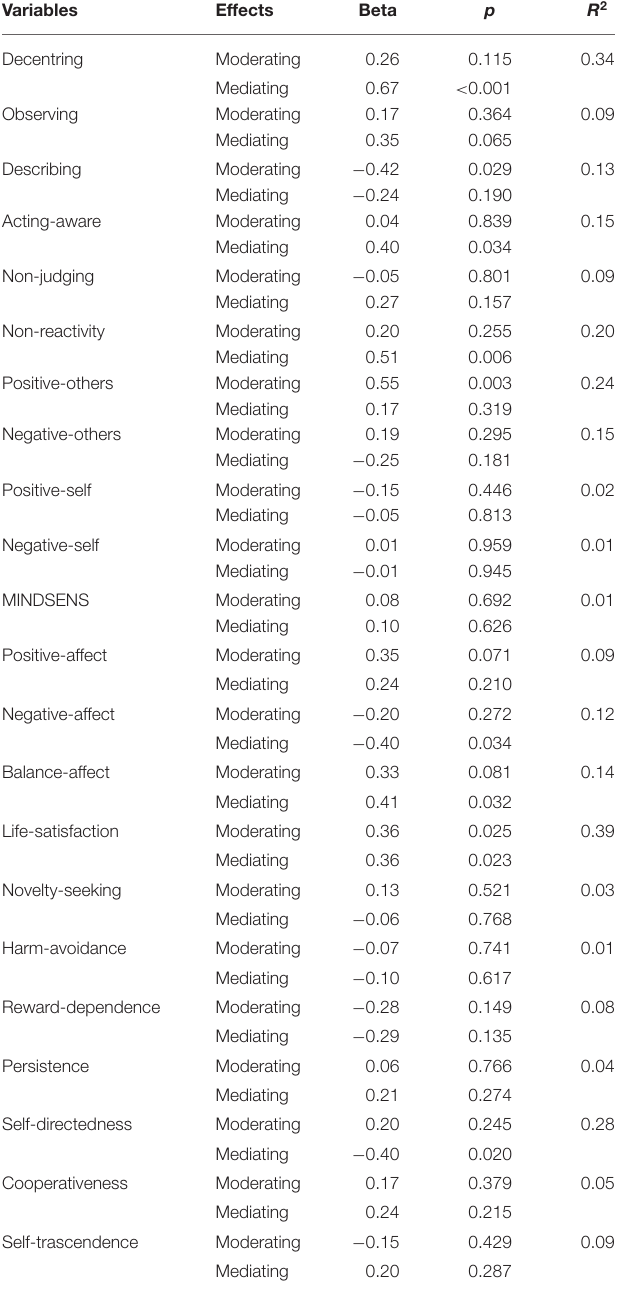
TABLE 4 | Moderating/mediating effects of non-attachment in mindfulness, well-being, and personality.